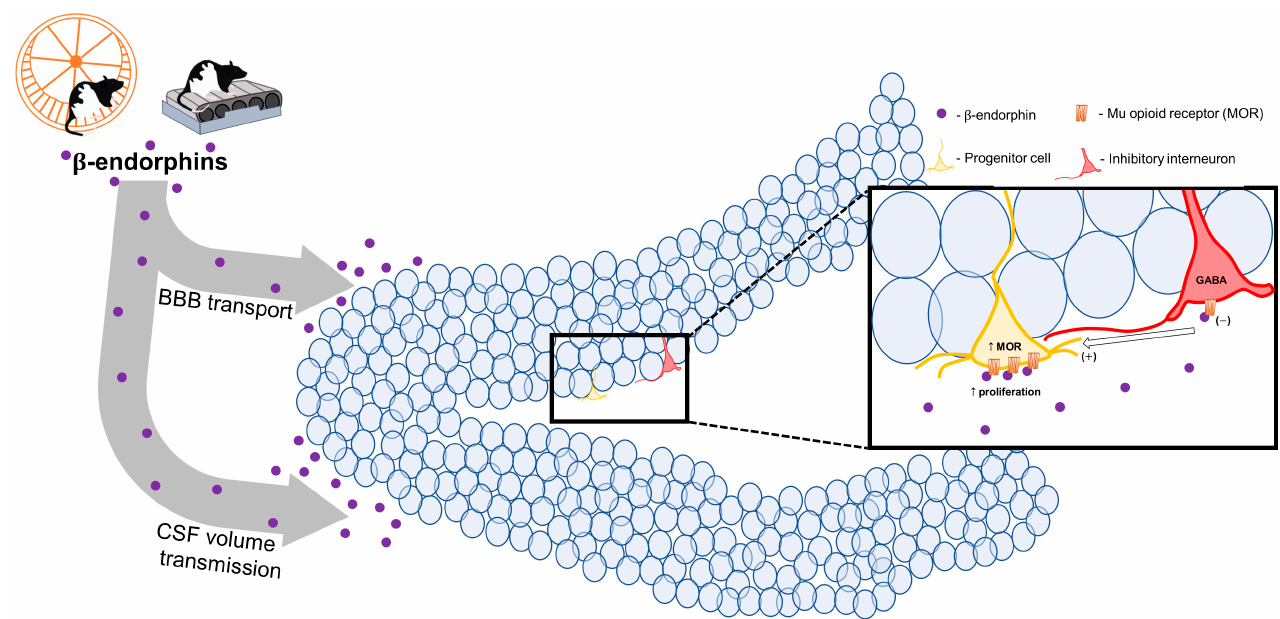
Figure 1. Proposed β -endorphin influence on adult neurogenesis following exercise. During multiple types of exercise, β -endorphins are released peripherally, which may signal in the dentate gyrus either through transport across the blood– brain barrier (BBB) or direct infusion into cerebrospinal fluid (CSF) and to the hippocampus via volume transmission. Once at the dentate gyrus, β -endorphins may enhance cell proliferation by both directly inducing proliferative activity in progenitor cells from acting on mu opioid receptors (MOR), which upregulate during exercise, or enhancing local net excitation by inhibiting GABAergic interneurons.